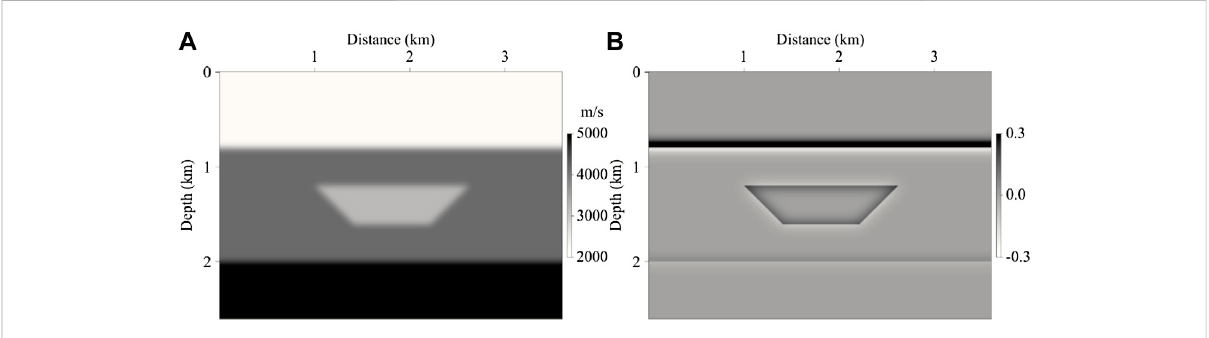
Figure 3C), the anisotropic migration imaging can effectively suppress the imaging noise and artifacts, and make the diffraction wave accurately homing. However, due to ignoring the absorption attenuation of the medium, the energy of the deep events is weak and the image is not clear enough. In the result of viscoacoustic VTI RTM (shown in Figure 3D), the imaging result can be regarded as an uncompensated VTI RTM image. The diffraction wave in the image converges and the imaging position of the re fl ection interface is more accurate. The deep energy is not restored, and the energy of the events is weak and not clear. There